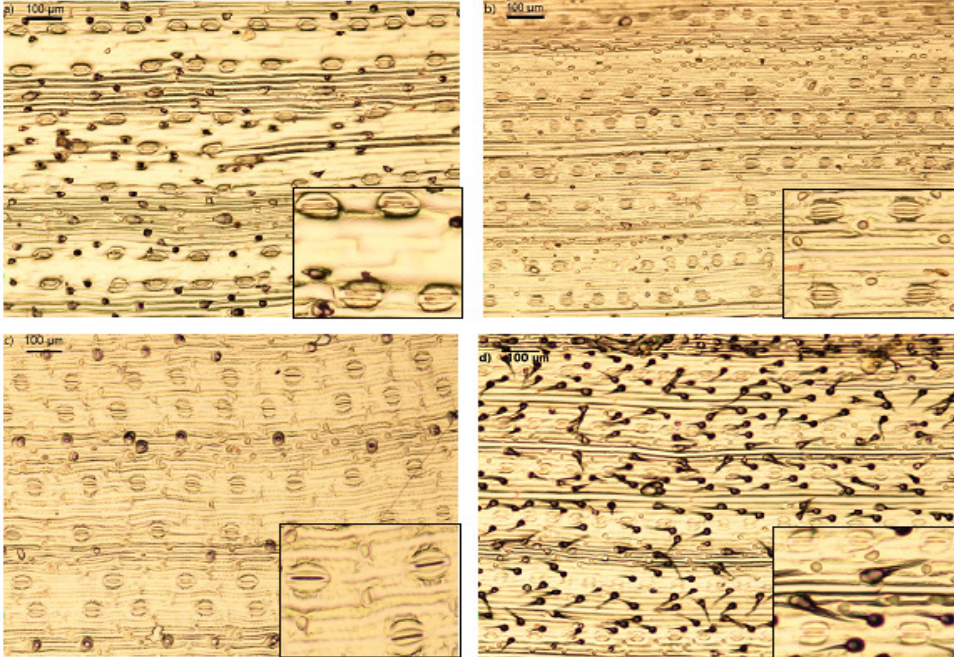
Figure 1. Stomatal diversity in wheat species and hybrids Scale bar is 100 µm. The images are captured from the adaxial epidermal layers after imprinting of flag leaf tissues. Figure 1a is a representative of the fewest stomata in ‘Agrotriticum’ among the studied genotypes, figure 1b is a representative of the highest density of the smallest stomata in T. durum cv. ‘Kunduru 1149’. Figure 1c indicates the largest size of stomata in ‘Aegilotriticum’ among the genotypes. Figure 1d shows stomata and typical more trichomes on epidermis of leaf in T. carthlicum . Black lined boxes are the zoomed part of the leaves showing stomatal